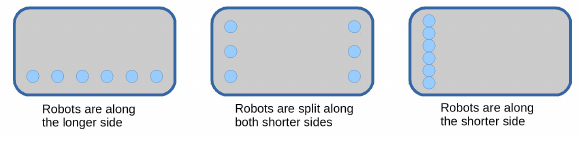
Figure 7: Robotic group start configurations.